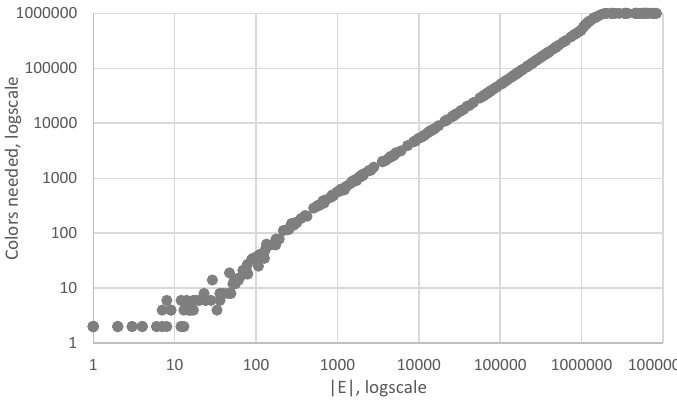
Figure 4. Number of colors needed w.r.t. the number of